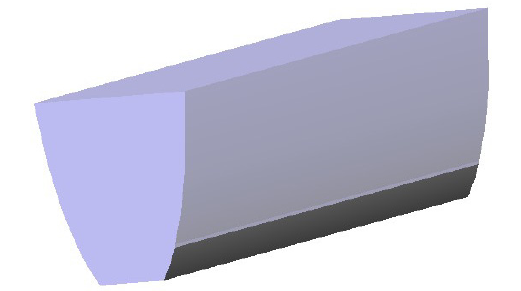
Figure 11. A schematic diagram of the partially coated truncated solid dielectric CPC.